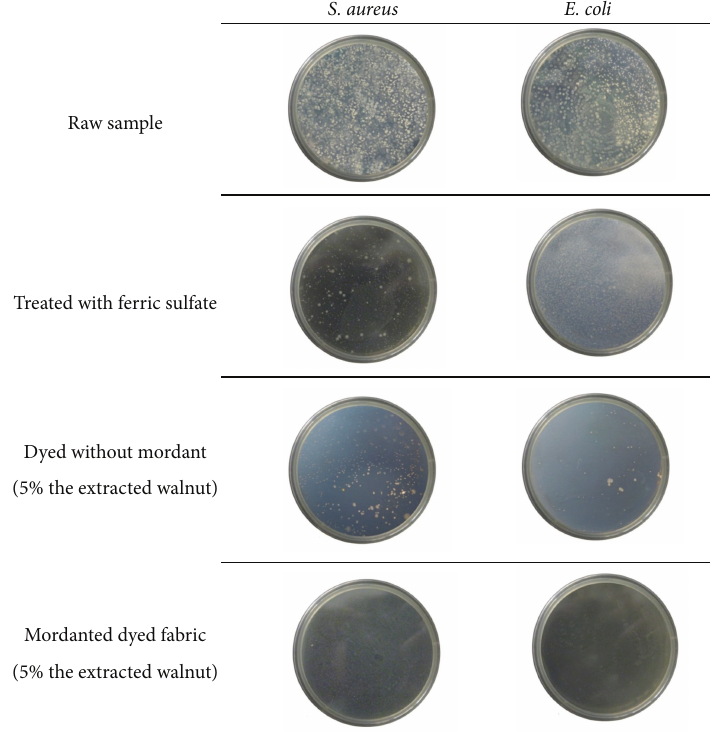
Figure 6: The antibacterial activity of the blank and treated